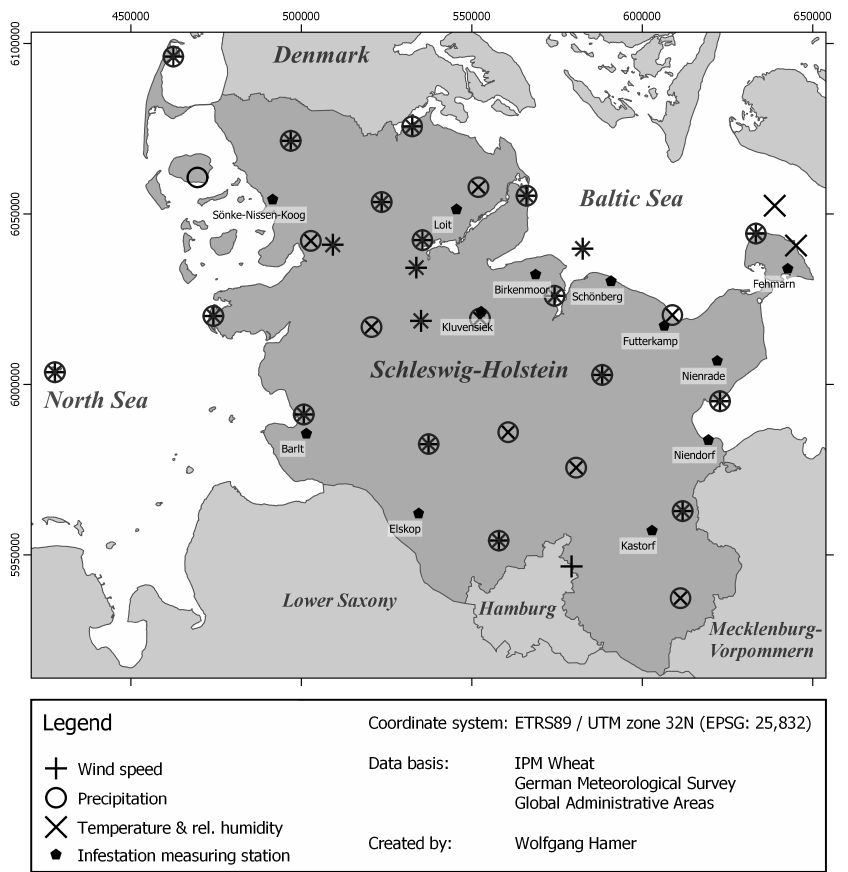
Figure 1. Map of the exemplary study area containing information on the weather and infestation measuring